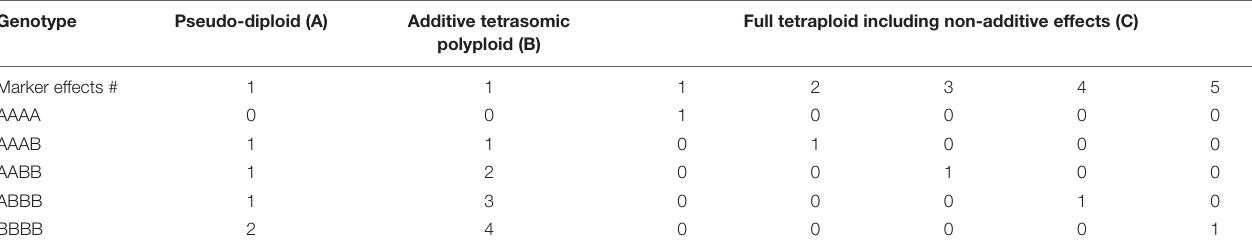
TABLE 1 | Coding of the design matrix for bi-allelic single nucleotide polymorphisms (A or B alleles) in a polysomic tetraploid potato considering pseudo-diploid (A), additive tetrasomic polyploid genotypes (B), and full tetraploids including non-additive effects (after Slater et al., 2016). Genotype Pseudo-diploid (A) Additive tetrasomic Full tetraploid including non-additive effects polyploid (B)